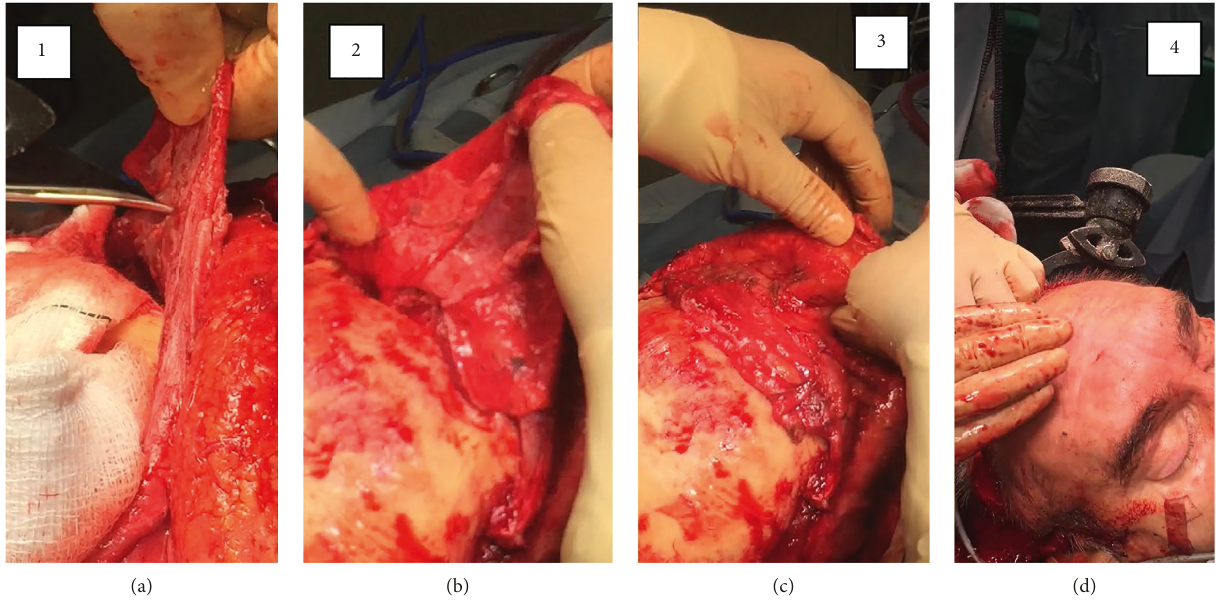
Figure 4: Obliteration of sinus defect. (a) Incisions bilaterally to improve manipulation capacity. (b) Roll edges of pedicled flap into sinus defect. (c) Central compartment folded over to smoothen sinus defect. (d) Replace skin, with further external manipulation of pericranial/ galeal soft tissue